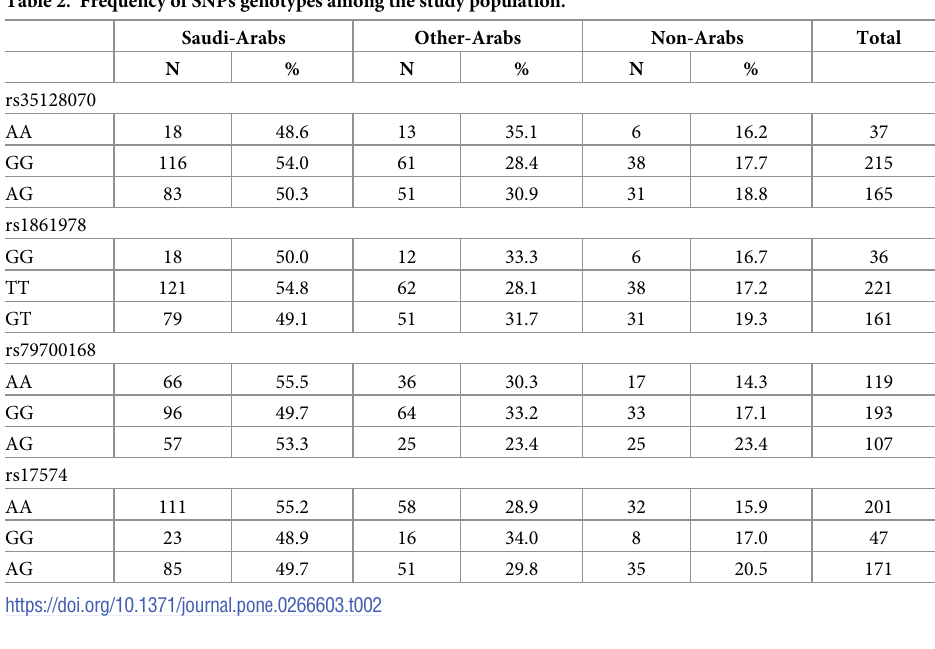
Table 2. Frequency of SNPs genotypes among the study population.